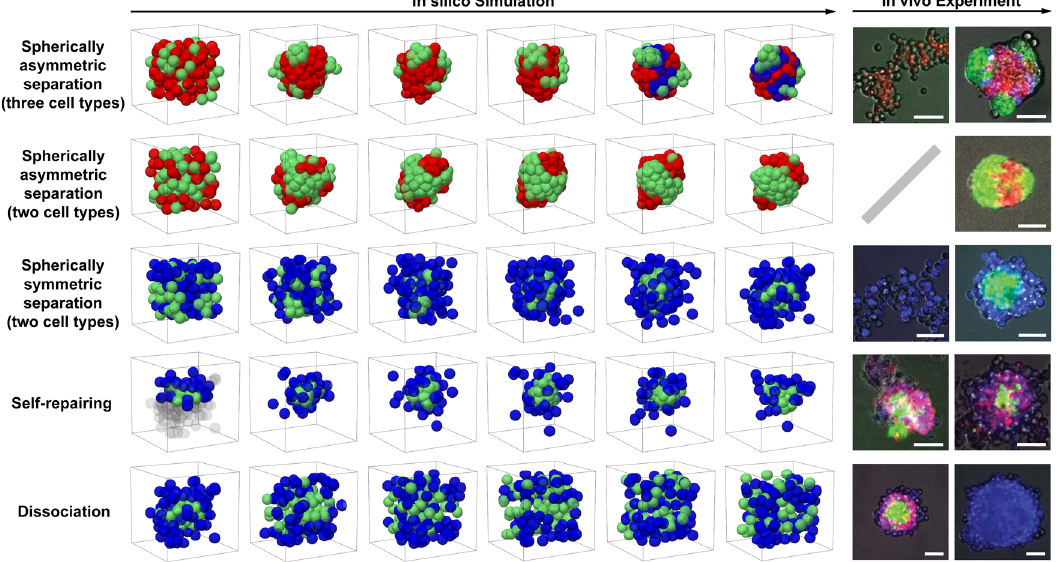
Fig. 6 In silico simulation (left panel) and in vivo experiment (right panel) of the synNotch systems. In each row, the in silico structures are shown from time points 0 to 50,000 in a step of 10,000; the computational domain is outlined with a black cube. In the fi rst row, since in silico time = 40,000 (the fi fth column), a part of red cells, which contact at least one green cell, are painted blue considering that the red cells (Type 1) receive contact-dependent signaling from the green cells (Type 2) and undergo subsequent differentiation into the blue cells (Type 3), in accordance to the experimental description 16 . In both the fourth and fi fth rows, the fi rst in silico structure is adopted from the last one in the third row; for the former one, the cells with z < 0 or without contact with the cell aggregate are removed and shown by gray shadow. For the in silico structures, the cell types and corresponding colors and value assignments on cell – cell adhesion are listed in Table 2. For the in vivo structures, the scale bars represent 100 μ m in reality; the fl uorescence colors are in line with the ones used for the in silico structures, except that the red cells in the fourth and fi fth rows also correspond to the blue ones in silico as they are the same in the cell – cell adhesion program. The images of in vivo experiment are from ref. 16 , reprinted with permission from